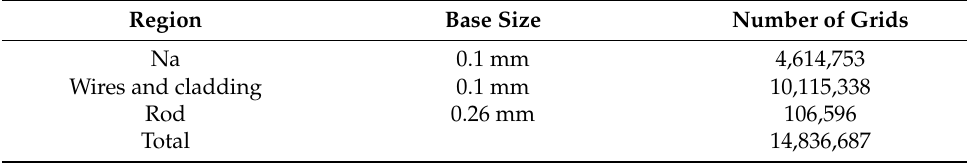
Table 6. Details of solid model grids.